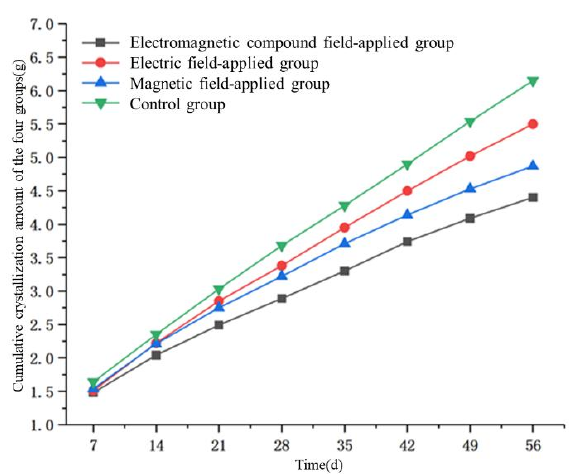
Fig. 6. Changes of the number of cumulative crystalline matter of the four groups over